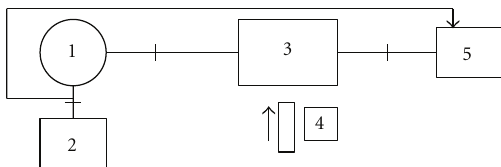
Figure 1: Scheme of the equipment for measuring the microwave properties 1: represent a set of generators for the whole range: HP686A and G4-79 to 82; 2: coaxial section of the deck E2M Orion, with samples of material; 3: power meter HP432A; 4: scalar reflectance meter HP416A; R : Reflect meter, including (i) two directional couplers Narda 4222.16; (ii) two crystal detectors Narda 4503-N.